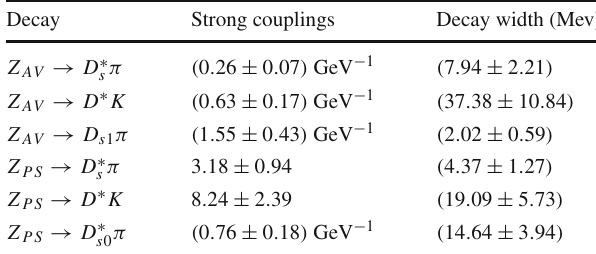
Table 3 The strong couplings and decay widths of the Z AV and Z PS tetraquarks Decay Strong couplings Decay width